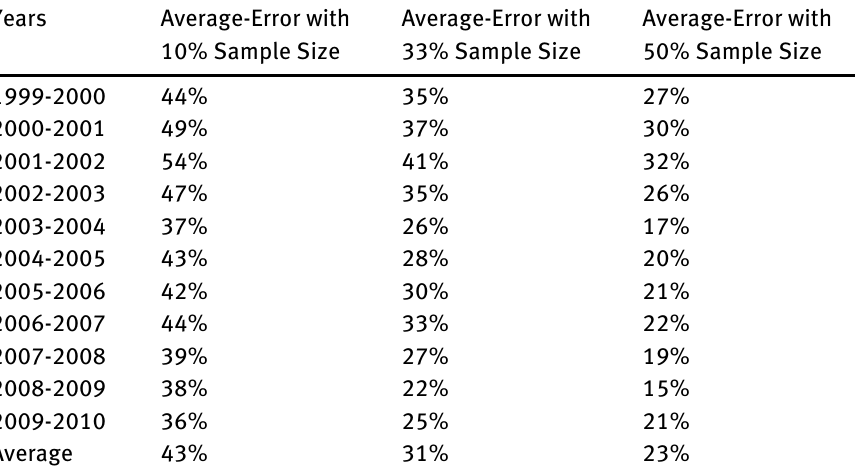
Table 1: Results of Random Forests prediction on a dataset built by proximity based contagion with full tree growing sample and 10%, 33% or 50% stress sample size. The errors are shown in % of the underlying